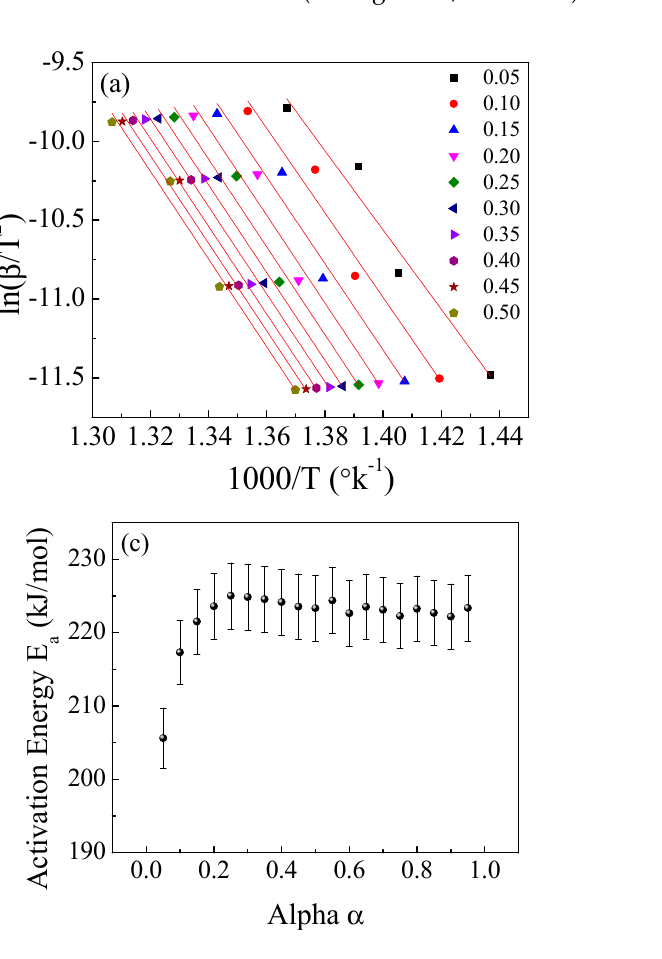
Alpha α (d) Figure 9. The Flynn − Wall − Ozawa (FWO) method for the EPDM host composite: ( a , b ) ln( β /T2) versus 1000/T; ( c , d ) the dependence of E a and A, respectively, on conversion α .